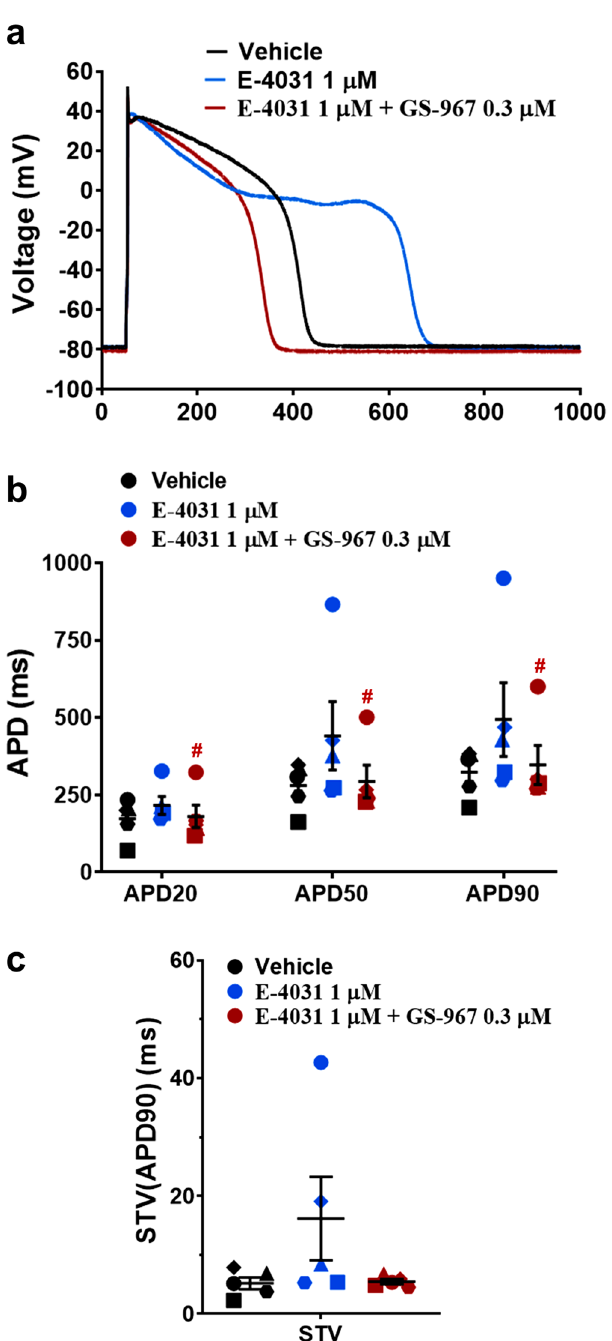
Figure 4. Effects of GS-967 on human ventricular action potential in condition mimicking LQTS2. ( a ) Typical action potentials (APs) recorded from a ventricular cell at a pacing of 1 Hz in the presence of vehicle control and after exposure to 1 µM E-4031 alone or in combination with 0.3 µM GS-967. ( b ) and ( c ) show mean % changes in APD (measured at 20% (APD20), 50% (APD50) and 90% (APD90) of repolarization) and STV(APD90), short-term variability of APD90 induced by addition of E-4031 alone or in the presence of GS-967 (n = 5 cells) at 1 Hz. # p < 0.05 versus values from E-4031. Fitmaster analysis software package (HEKA Elektronik, Germany, www. heka. com) and SigmaPlot v14.0 (Systat Software Inc., CA, USA, www. systa tsoft ware. com) were used to generate the representative AP